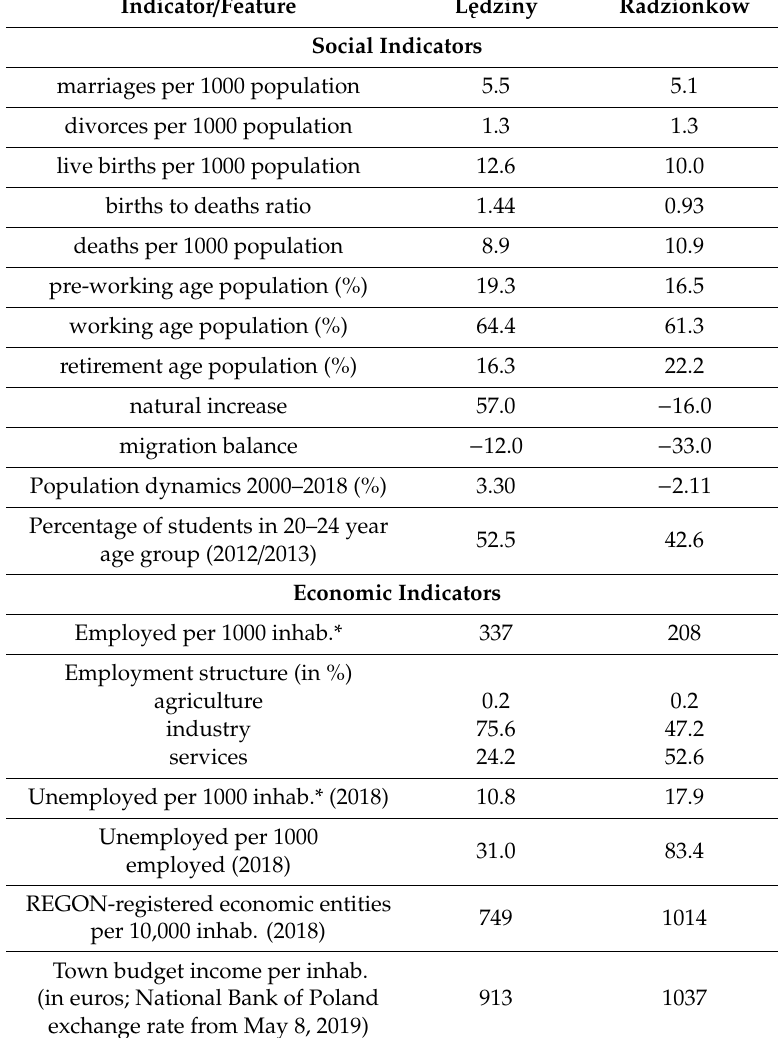
Table 1. Economic and social situation of L˛edziny and Radzionk ó w in 2017. Own elaboration on the base of [57,58].